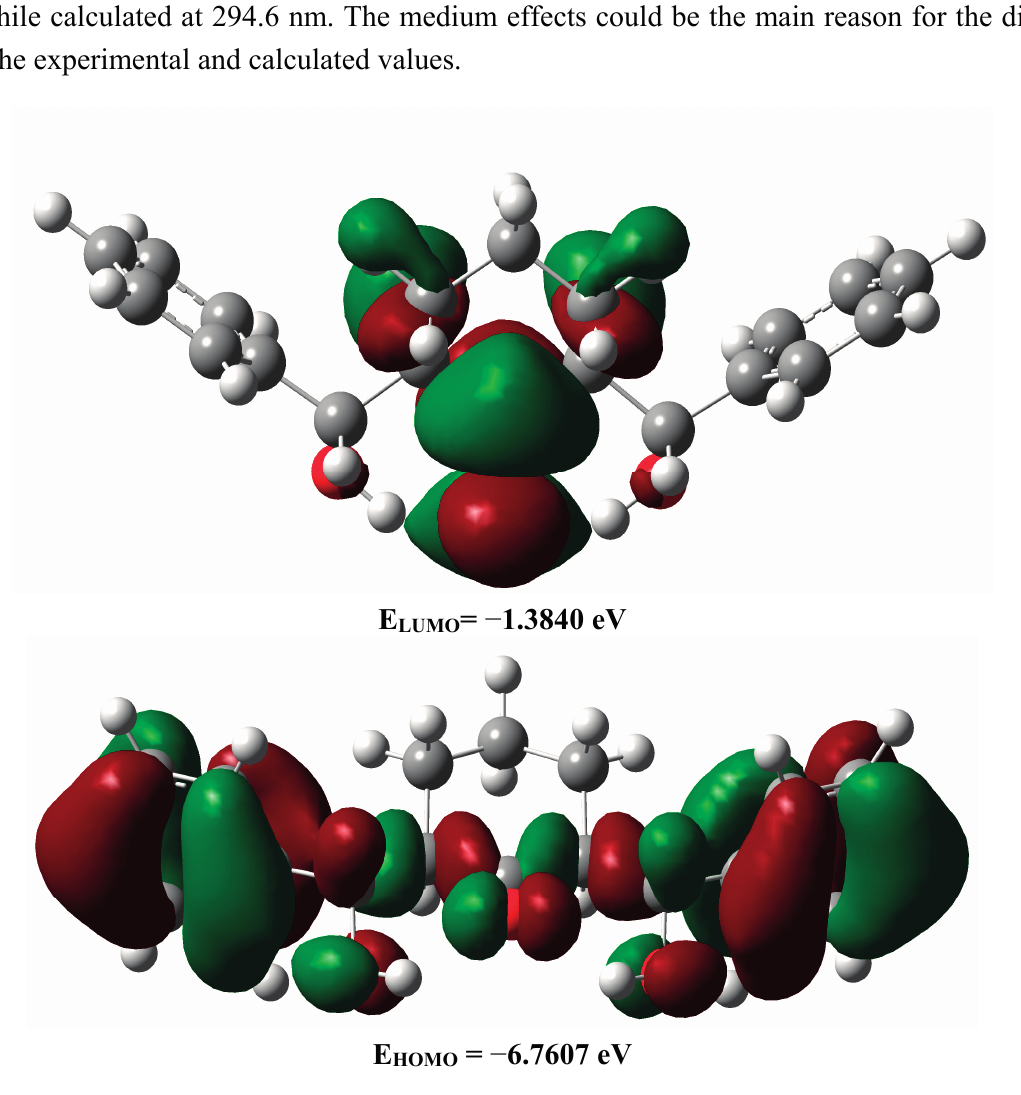
Figure 7. The ground state isodensity surface plots for the frontier molecular